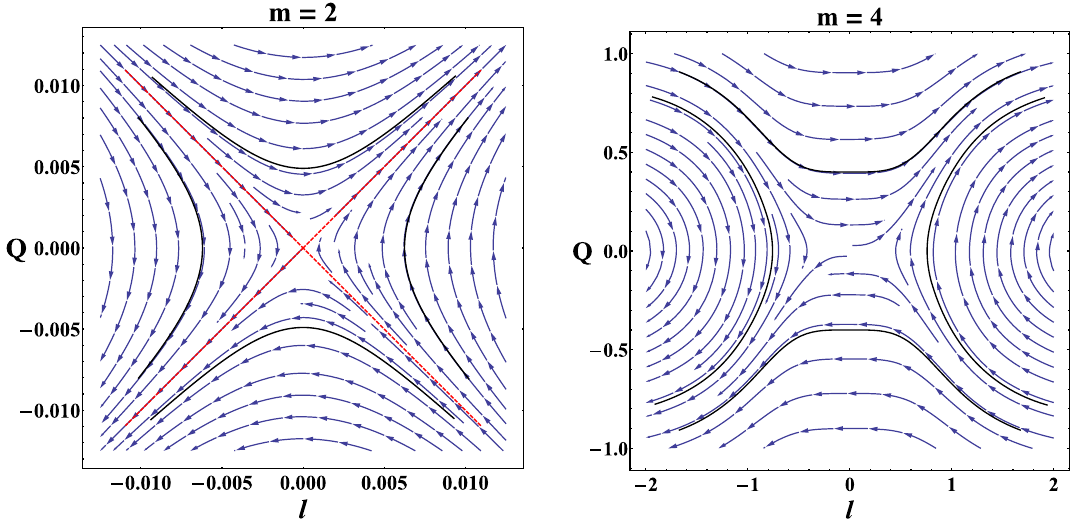
Fig. 4 Phase-space-plot for the coupled system corresponding to geodesic equation Eq. (46) for m = 2 , 4). Here, we are considering b 0 = 1 and h =